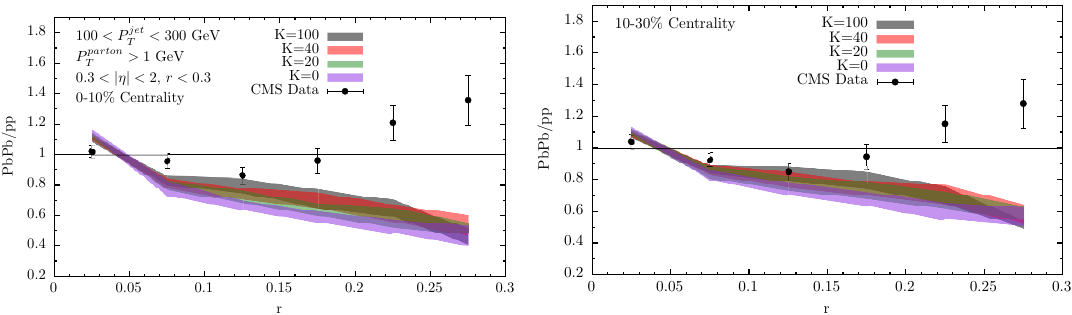
Figure 5 . Left: ratio of the jet shape in PbPb collisions to that in proton-proton collisions for di(cid:11)erent values of the broadening parameter K as compared to CMS data from heavy ion collisions with p s = 2 : 76 ATeV [51] and 0-10% centrality (left) or 10-30% centrality (right). jets with p jet